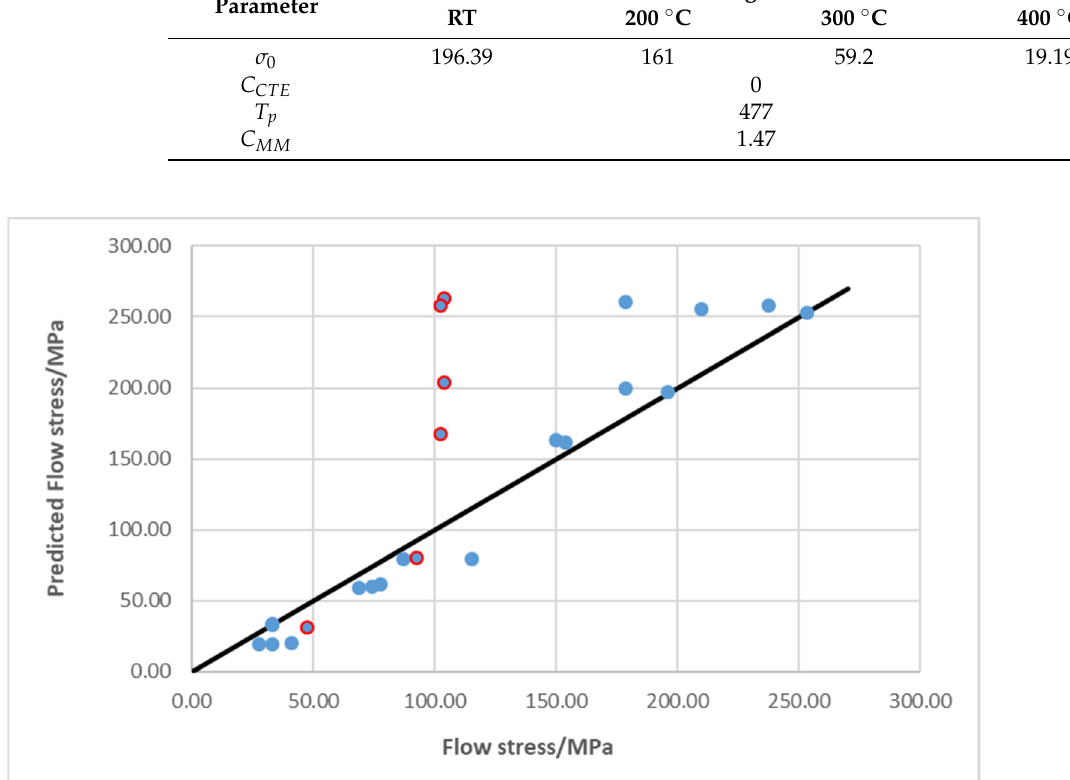
Figure 8. Model fit to experimental data showing the flow stress from the model prediction, Equations (1–4) versus the experimentally obtained flow stress. The red points are the data omitted in the fitting due to the brittle behavior.